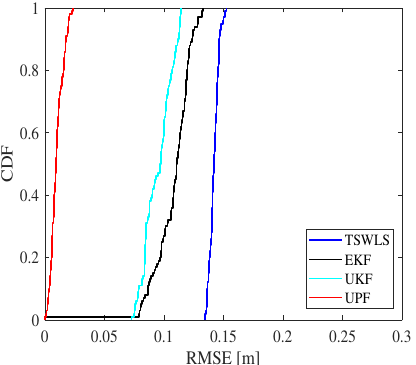
= 0.5 ◦ , σ = 0.1 d i i